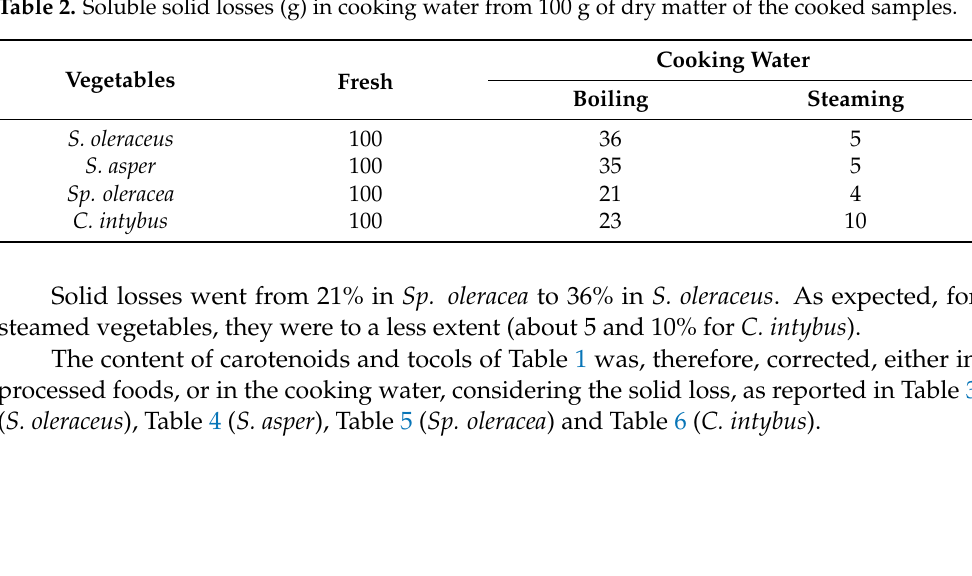
Table 2. Soluble solid losses (g) in cooking water from 100 g of dry matter of the cooked samples. Vegetables Fresh S. oleraceus 100 36 5